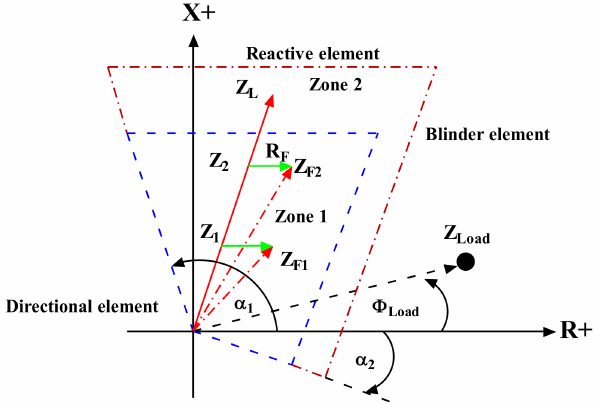
Figure 3. Quadrilateral characteristics with zones of distance